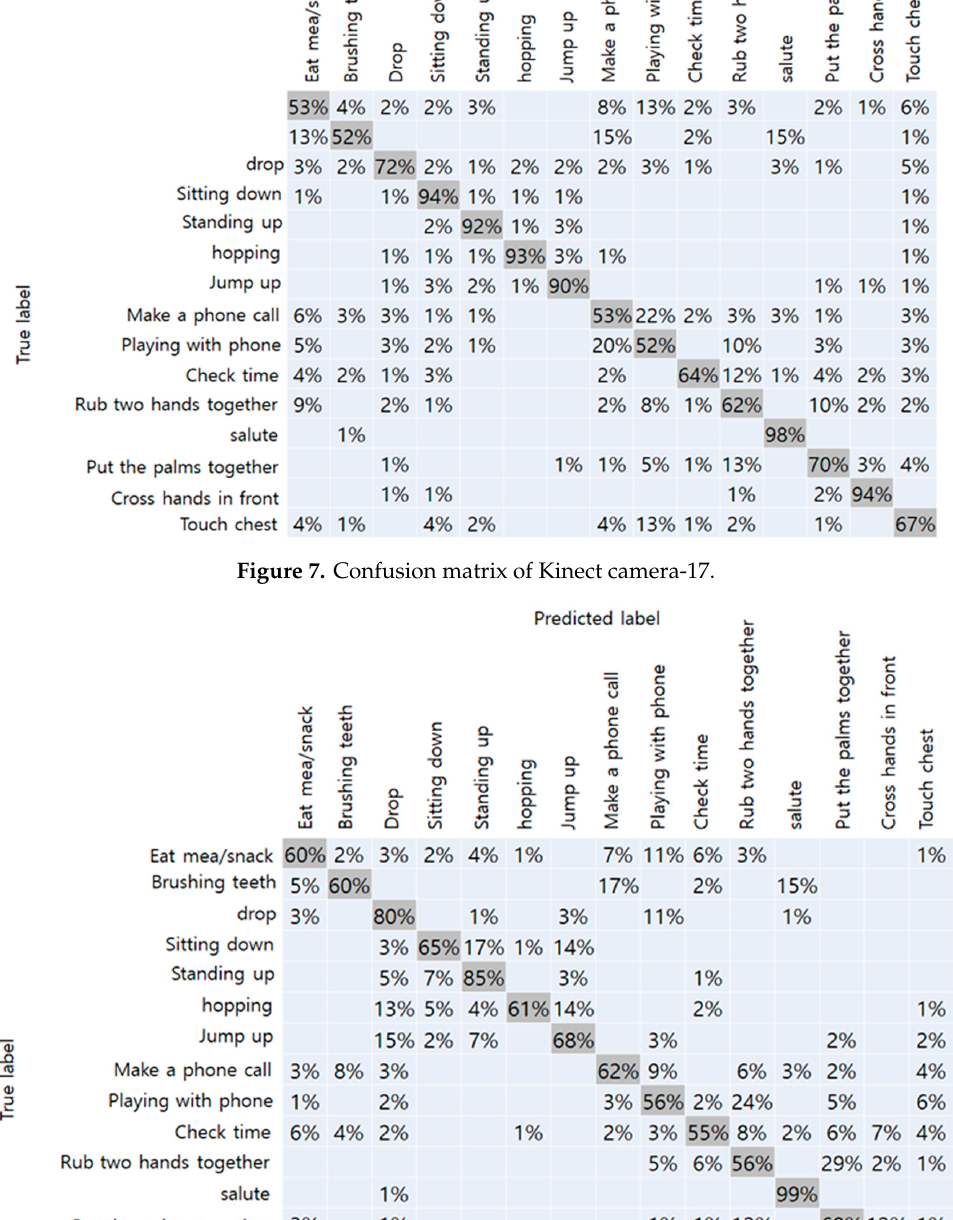
Figure 8. Confusion matrix of RGB camera-17.